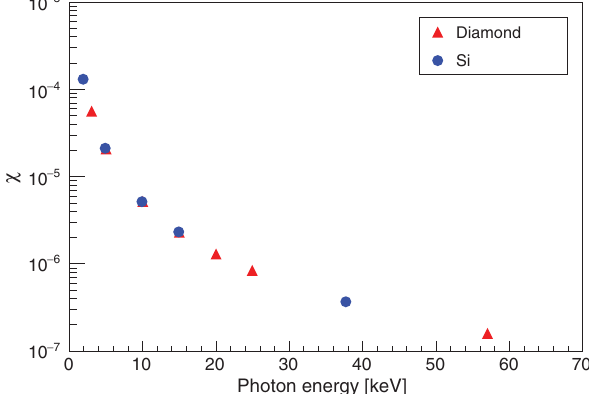
FIG. 6. Schematic of the PXR chamber.